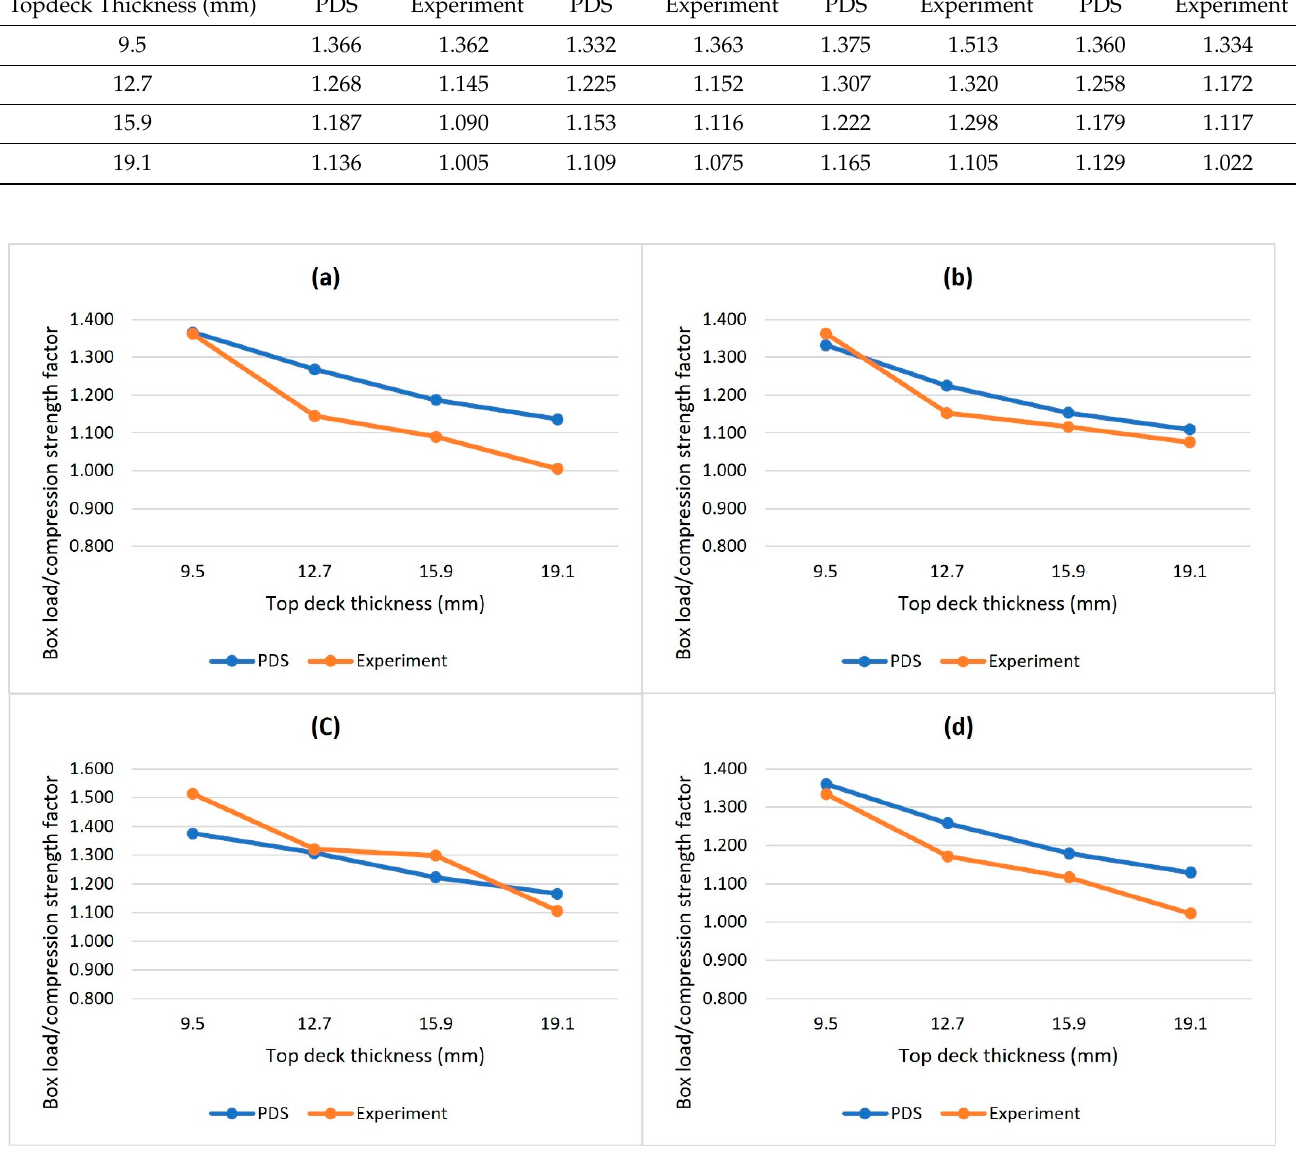
Figure 4. Comparison of box load factors and box compression strength factors of each type of boxes in response to pallet top-deck thickness. ( a ) Small C-flute box scenarios, ( b ) shows large C-flute box scenarios, ( c ) shows small B-flute box scenarios, and ( d ) shows large B-flute box